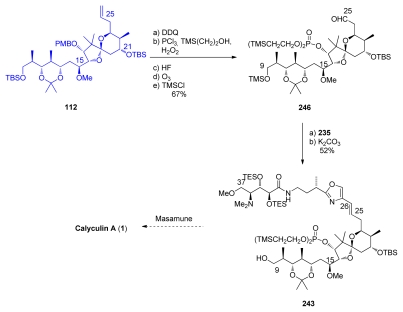
Preparation of 243.